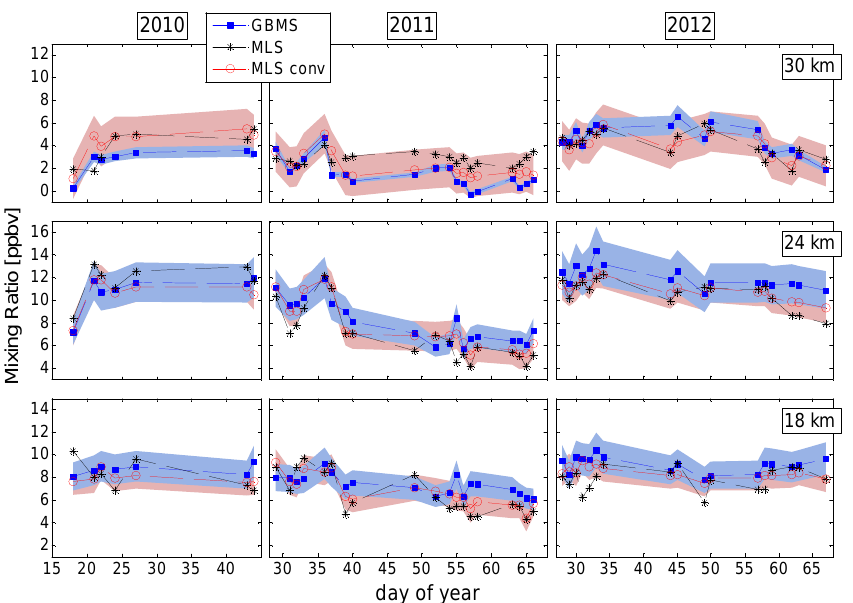
Fig. 7. Same as in Fig. 4, but for HNO 3 data. HNO 3 values are displayed at 18, 24 and 30km altitude. Figure 7. Same as in Figure 4, but for HNO 3 data. HNO 3 values are displayed at 18, 24 and 30 2 km altitude. 3